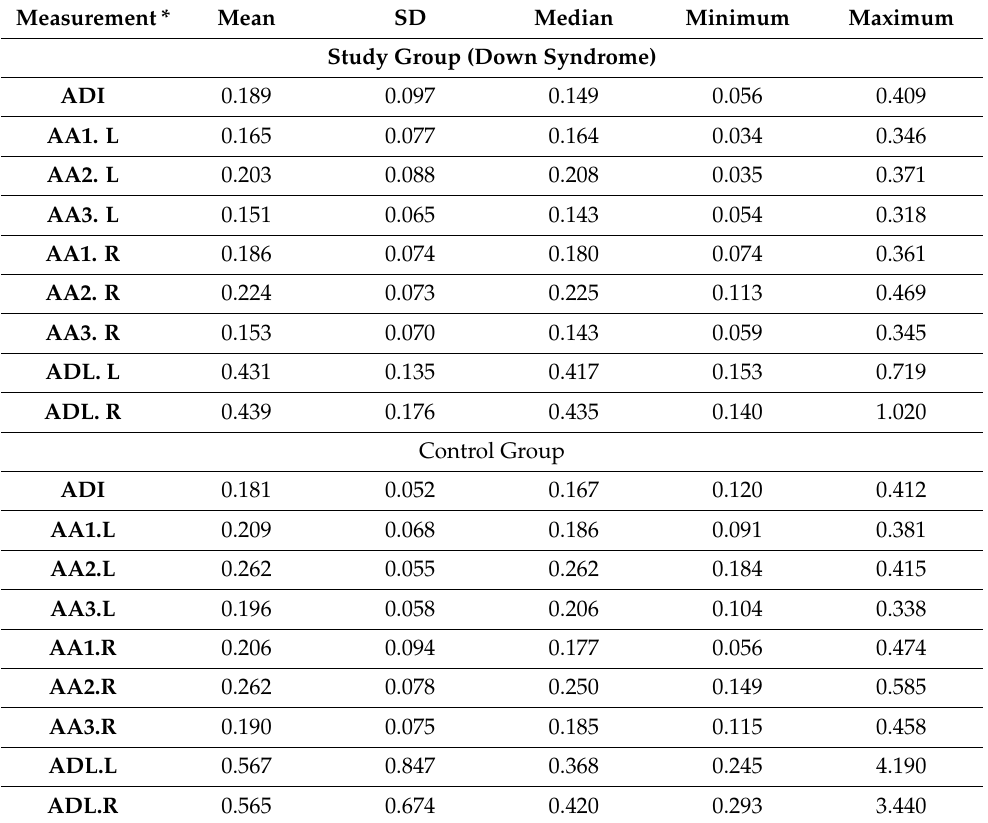
Table 1. Atlantoaxial Measurements in the Study (Down Syndrome) and Control Group. Measurement * Mean SD Median Minimum